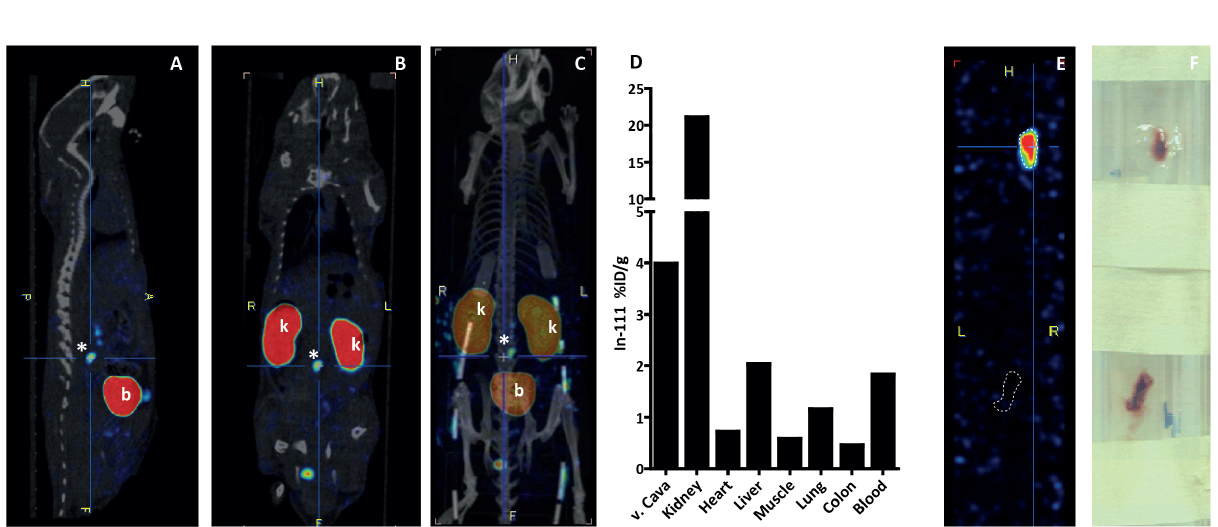
Figure 6. Representative SPECT/CT overlays of sagittal ( A ) and coronal ( B ) views, and a 3D model ( C ) of a mouse 6 hr after IVC ligation, injected with 111 In-A16. High uptake of the tracer is seen in kidneys (k), bladder (b) and thrombus (*). ( D ) Accompanying biodistribution of this mouse showing high uptake in the V. cava and kidneys, expressed as percentage injected dose per gram tissue (%ID/g). ( E ) Ex vivo SPECT scan of the thrombus (top dotted line). The lower dotted line outlines the IVC of a sham-surgery mouse injected with 111 In-A16. ( F ) Light image of embedded